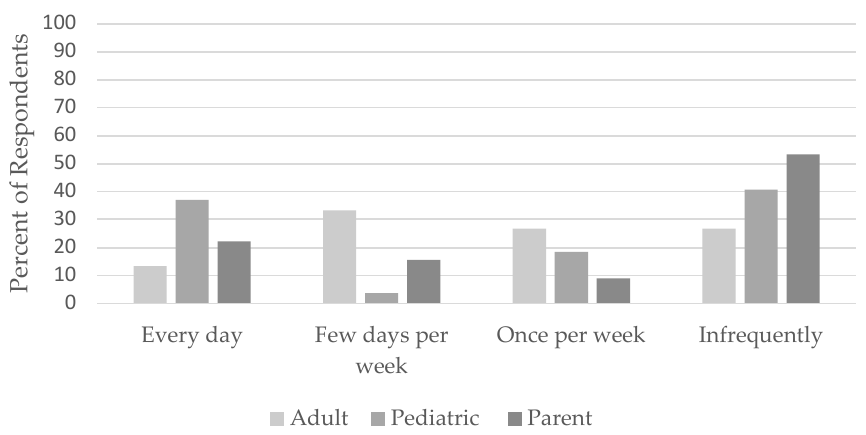
Figure 1. Ratings of pain frequency as reported by adult and pediatric self-report population, and parents of pediatric MTC patients of all ages. Pediatric self-report n = 27; parent report n = 45 Adult self-report n =